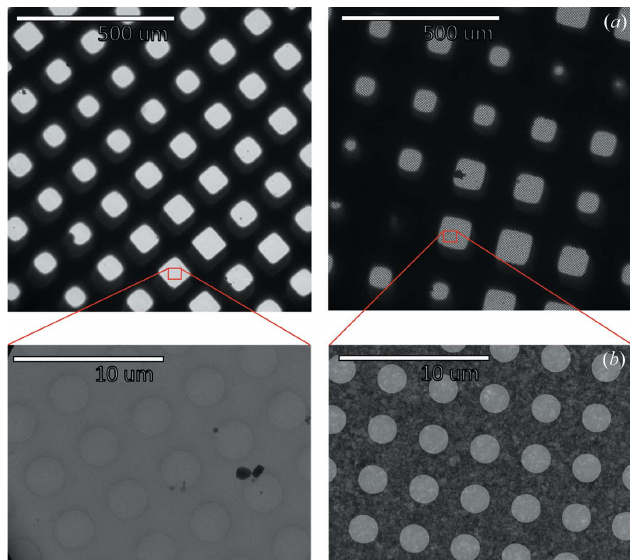
Figure 2 Example low- and medium-magnification images: carbon grid (left) and gold grid (right). First, low-magnification images of the grid, where squares are visible, are acquired at a pixel size of (cid:2) 200–500 nm pixel (cid:3) 1 . Subsequently, medium-magnification images are acquired at a pixel size of (cid:2) 10–100 nm pixel (cid:3) 1 by imaging the regions inside the squares.